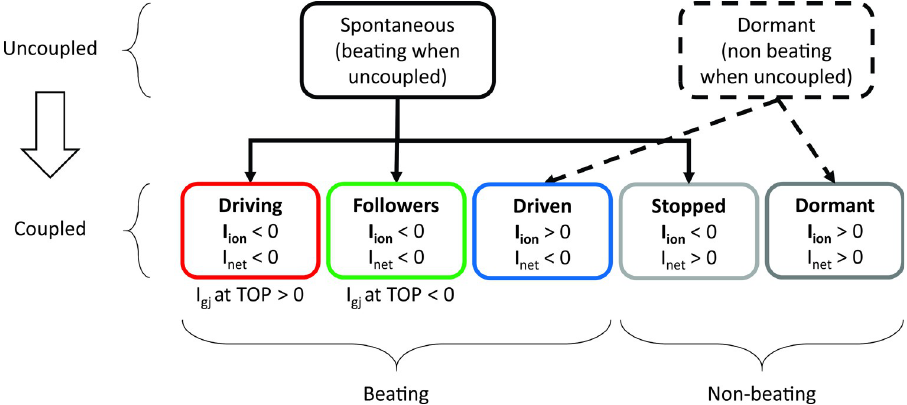
Fig 3. Cell categorization. Cells forming the tissue have been divided into different categories, depending on whether they exhibited action potentials, or not, under both coupled and uncoupled conditions. Alterations in intercellular coupling can cause an individual cell to switch categories, for instance from dormant at one value of coupling to driven at another